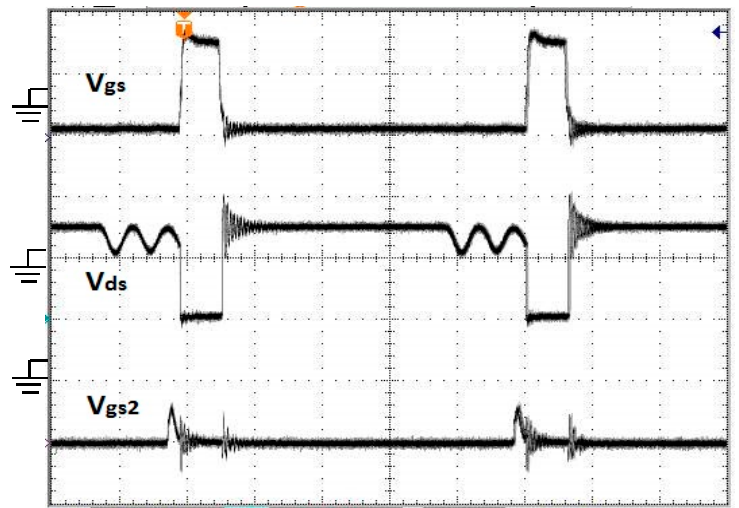
Figure 9. The valley-switching waveforms V gs , V ds , and V gs 2 at a light load when the input DC voltage is 380 V dc . ( V gs : 10 V / div, V ds : 10 V / div, V Gs 2 : 10 V / div, time: 2 µ s